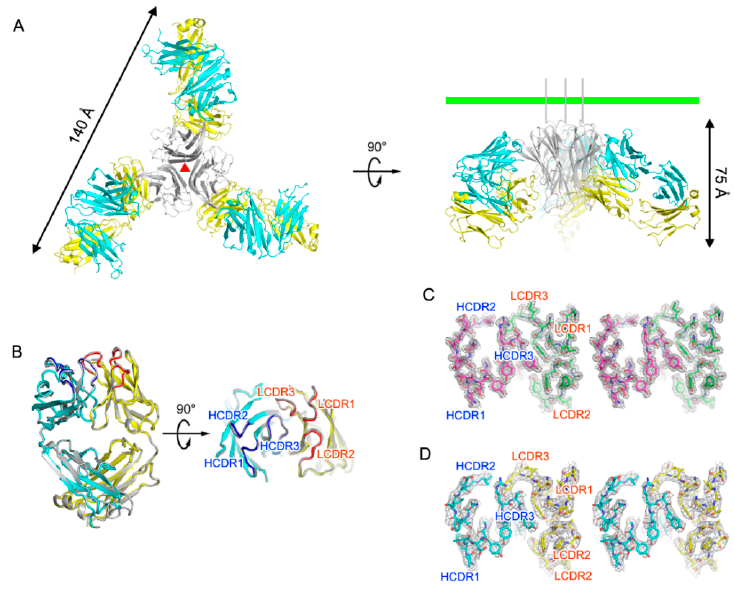
Figure 1. Overall structure of TNF α in complex with the certolizumab Fab fragment. ( A ) Ribbon representation of TNF α (gray) in complex with the certolizumab Fab fragment (heavy chain: cyan; light chain: yellow) in two orientations. The 3-fold axis in the trimeric complex is indicated as a red triangle. The green bar indicates a putative membrane of a TNF α -producing cell if the TNF α trimer is a precursor form of transmembrane TNF α ; ( B ) Superposition of the free certolizumab Fab fragment (gray) onto the Fab fragment extracted from the TNF α -certolizumab complex (heavy chain: cyan; light chain: yellow; heavy chain complementary-determining regions: blue; light chain complementary-determining regions: red); ( C ) Cross-eyed stereoview of the 2fo-fc composite omit map (1.2 σ contour level) at the complementary-determining regions (CDRs) of the free certolizumab Fab fragment, calculated at 1.95 Å resolution (heavy chain: purple; light chain: green); ( D ) Cross-eyed stereoview of the 2Fo-Fc composite omit map (1.2 σ contour level) at the CDRs of the Fab fragment in the TNF α -certolizumab complex, calculated at 2.89 Å resolution (heavy chain: cyan; light chain: yellow).